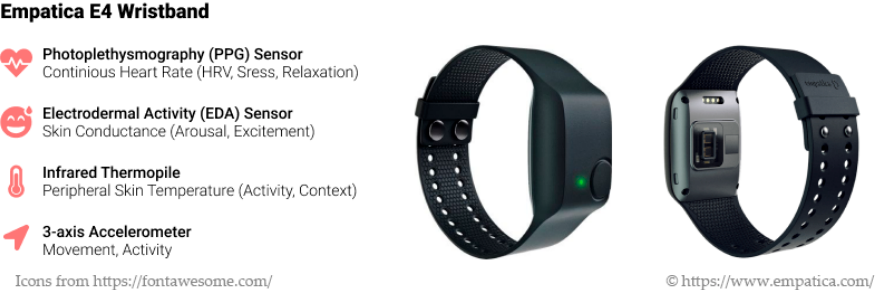
Figure 2. Empatica E4 wristband’s sensors (https://www.empatica.com/en-eu/research/e4/) (accessed on 3 February 2021).